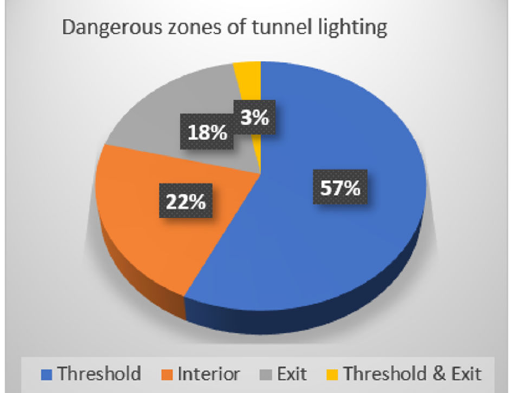
Figure 3. Dangerous zones of tunnel lighting.